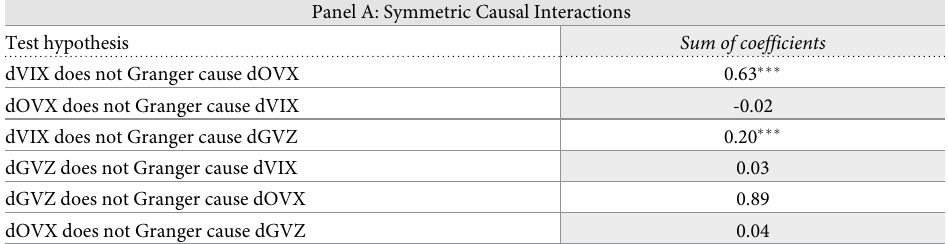
Panel A: Symmetric Causal